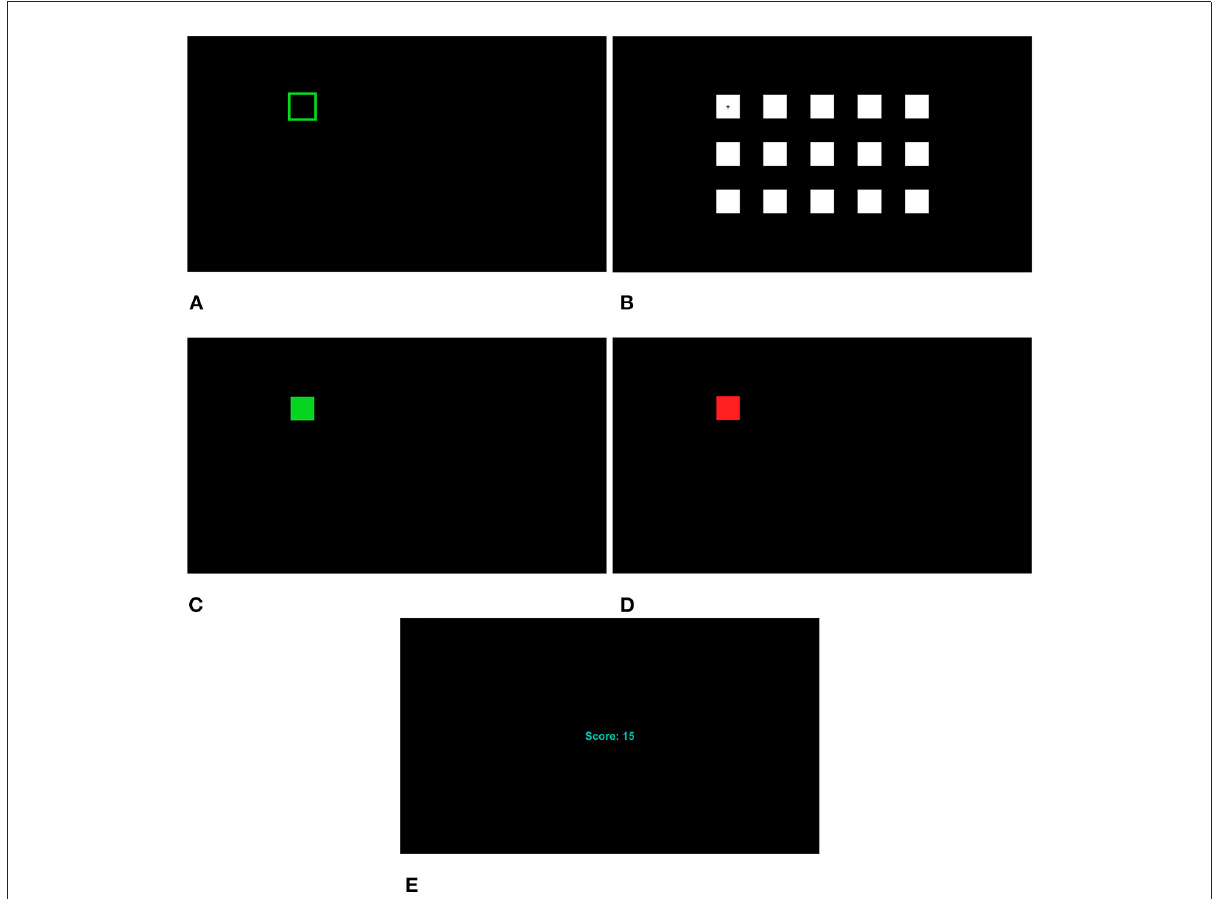
FIGURE3 Example of a 6-by-6 Sudoku in brickwall style.